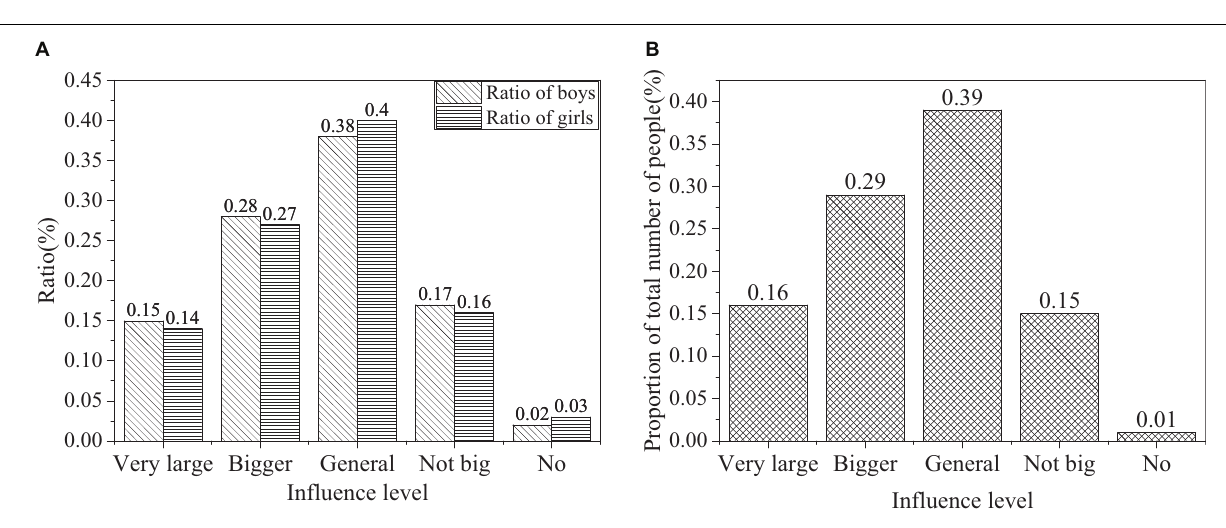
FIGURE 6 | Impact of network information on values of college students [ (A) the ratio of males and females; (B) the ratio of